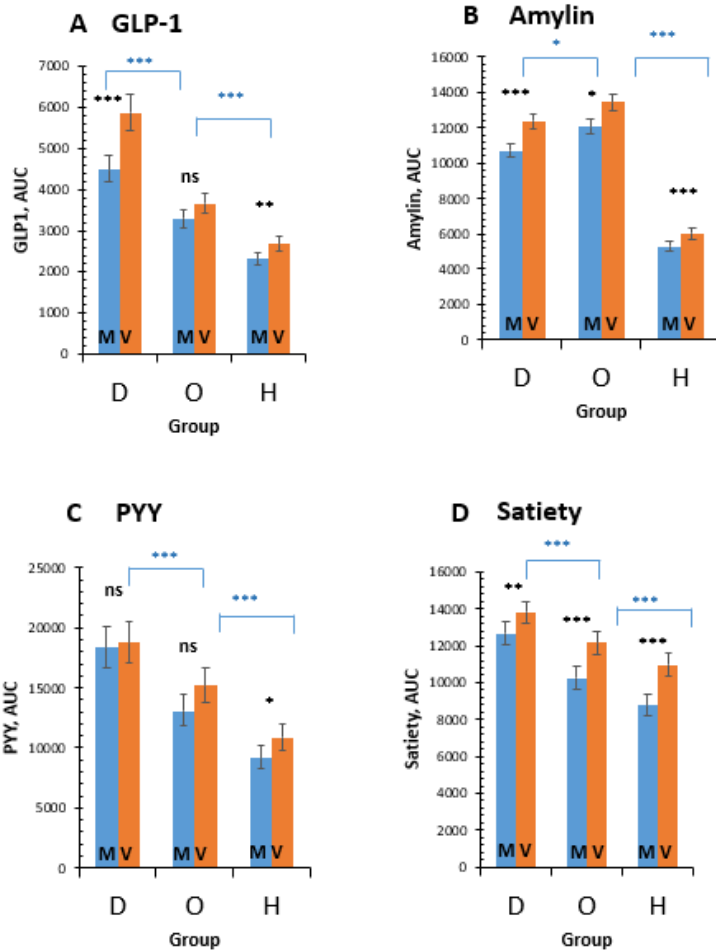
Figure 2. Postprandial changes in plasma concentrations of gastrointestinal hormones and in satiety in patients with diabetes (D), obese subjects (O), and healthy controls (H) after the ingestion of the processed-meat meat M-meal (M, blue) and the vegan V-meal (V, orange). Data are expressed as mean with 95% confidence intervals, using a repeated-measures Analysis of variance (ANOVA). * p <